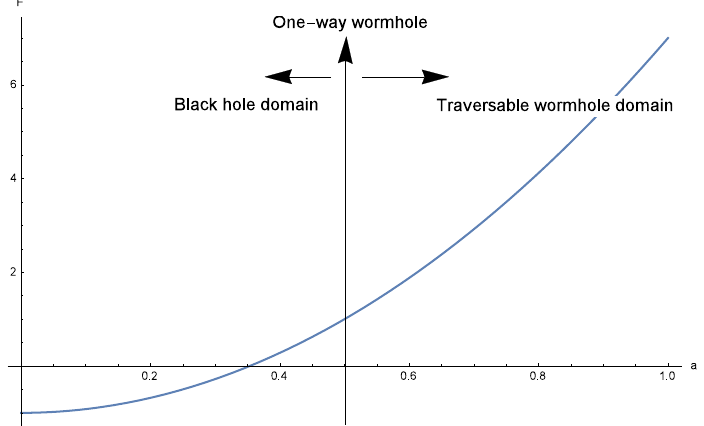
Figure 4. Free energy as a function of the regulator parameter a . For this plot, we used l = 0.5 and M =